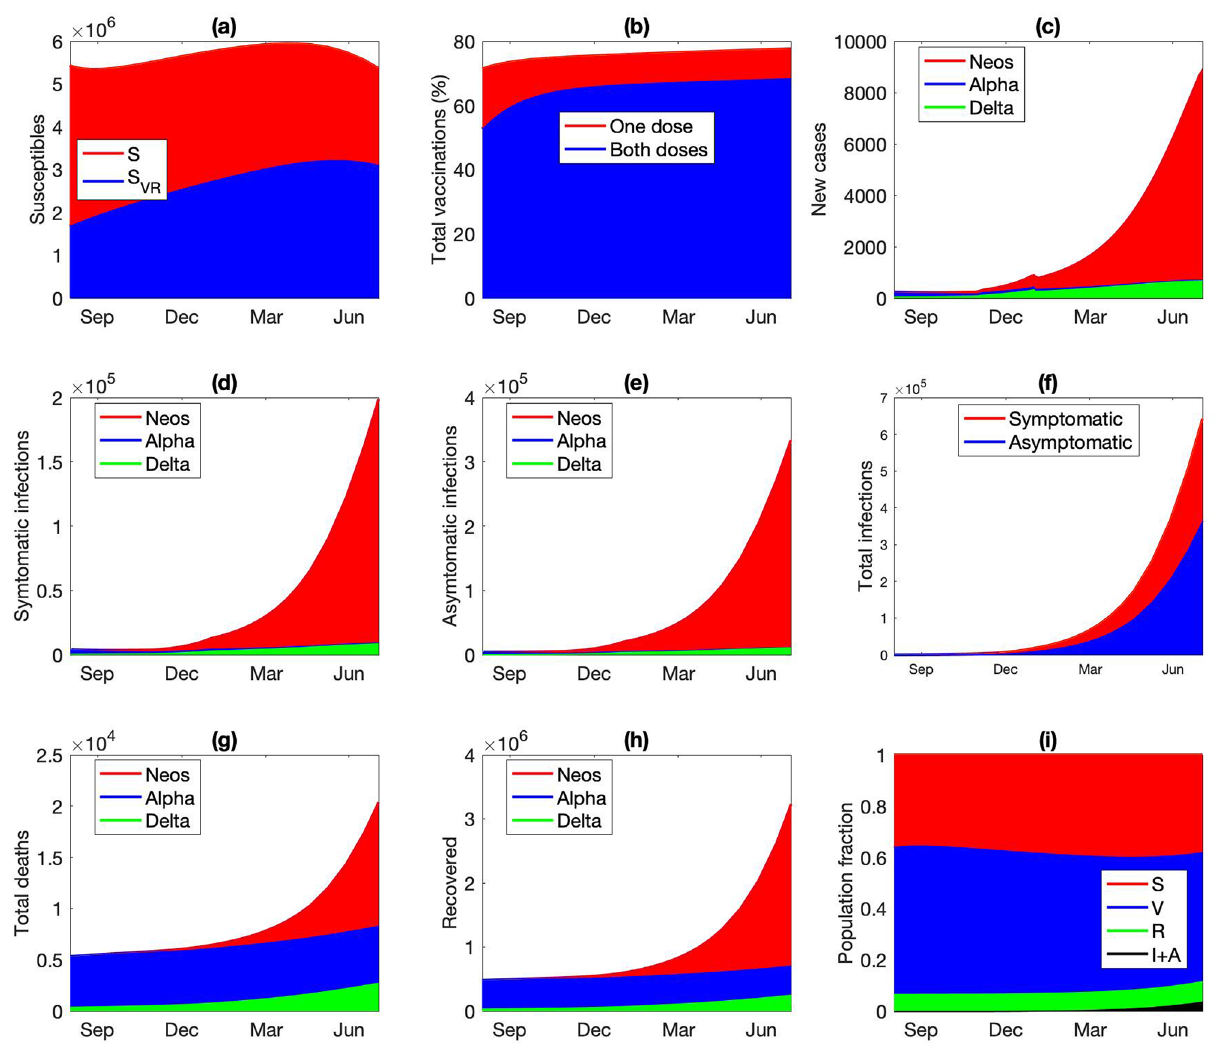
Figure 9. Dynamics of hypothetical VOC (“Neos”), simulated from August 1 2021 to June 31 2022. ( a ) Susceptible individuals, original population and those who lost their immunity acquired either from an infection or vaccination. ( b ) Vaccinated with only one dose or both, with either Pfizer (PZ) or AstraZeneca (AZ). ( c ) New infections per day (Neos, Alpha, Delta) since August 1 2021. ( d ) Total symptomatic infections since August 1 2021. ( e ) Total asymptomatic infections since August 1 2021. ( f ) Cumulative infections since August 1 2021. ( g ) Cumulative deaths from Neos, Alpha, and Delta. ( h ) Total number of individuals having recovered from Neos, Alpha, and Delta infections. ( i ) Fraction of population being susceptible, vaccinated (one or two doses), recovered, and infections (symptomatic or